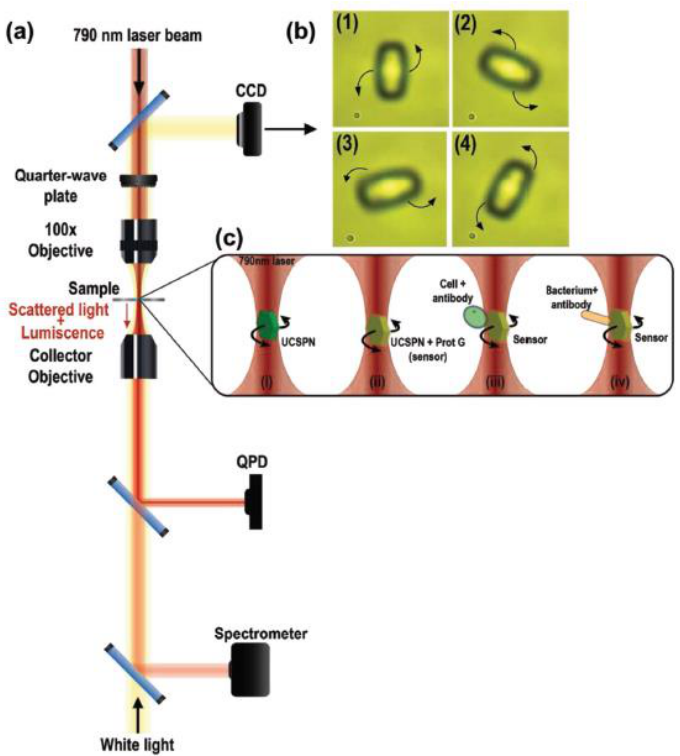
Figure 19. Upconverting spinners. ( a ) Schematic representation of the experimental set-up for optical trapping and rotation of Upconverting spinners (UCSPNs) and single-body biodetection. ( b ) The rotation speed of the UCSPN is determined by recording the intensity fluctuations of the transmitted laser beam using a Quadrant PhotoDetector (QPD) or polarized emission using a spectrometer and analyzing them in the frequency domain. Real-time visualization of the UCSPN, bacteria, and cells are possible, and some representative pictures of a UCSPN are included. ( c ) The different situations evaluated all along this work are also schematically represented: ( i ) trapping and rotation of a single and bare UCSPN, ( ii ) surface-functionalized UCSPN, ( iii ) surface-functionalized UCSPN with an attached cell, ( iv ) surface-functionalized UCSPN with an attached bacterium. The attachment of ei- ther a bacterium or a cell to the optically rotating UCNP leads to a remarkable change in the rota- tional velocity that is quantified from the frequency spectrum. (Reproduced with permission from [218]).